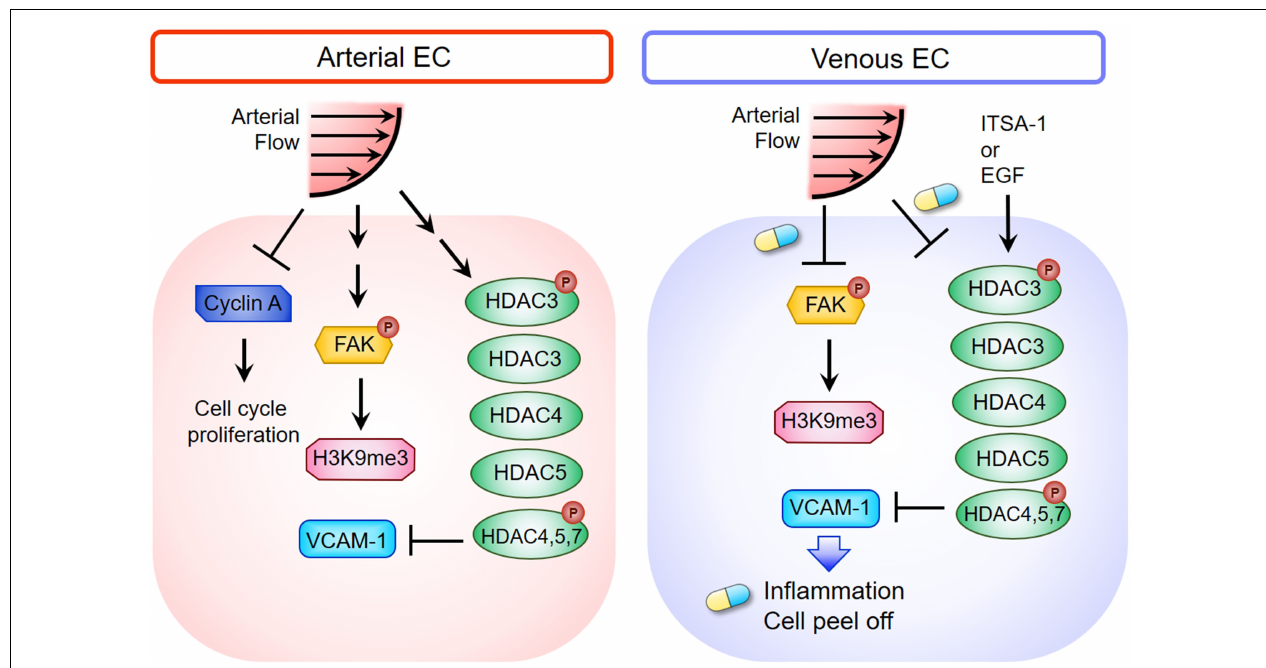
FIGURE 7 | Schematic diagram depicting the mechanism of HDACs and H3K9me3-mediated inflammation in triggering vEC damage under ALS stimulation. The blue and yellow capsule symbol means that the ALS-induced damages were rescued by treating with ITSA-1 or